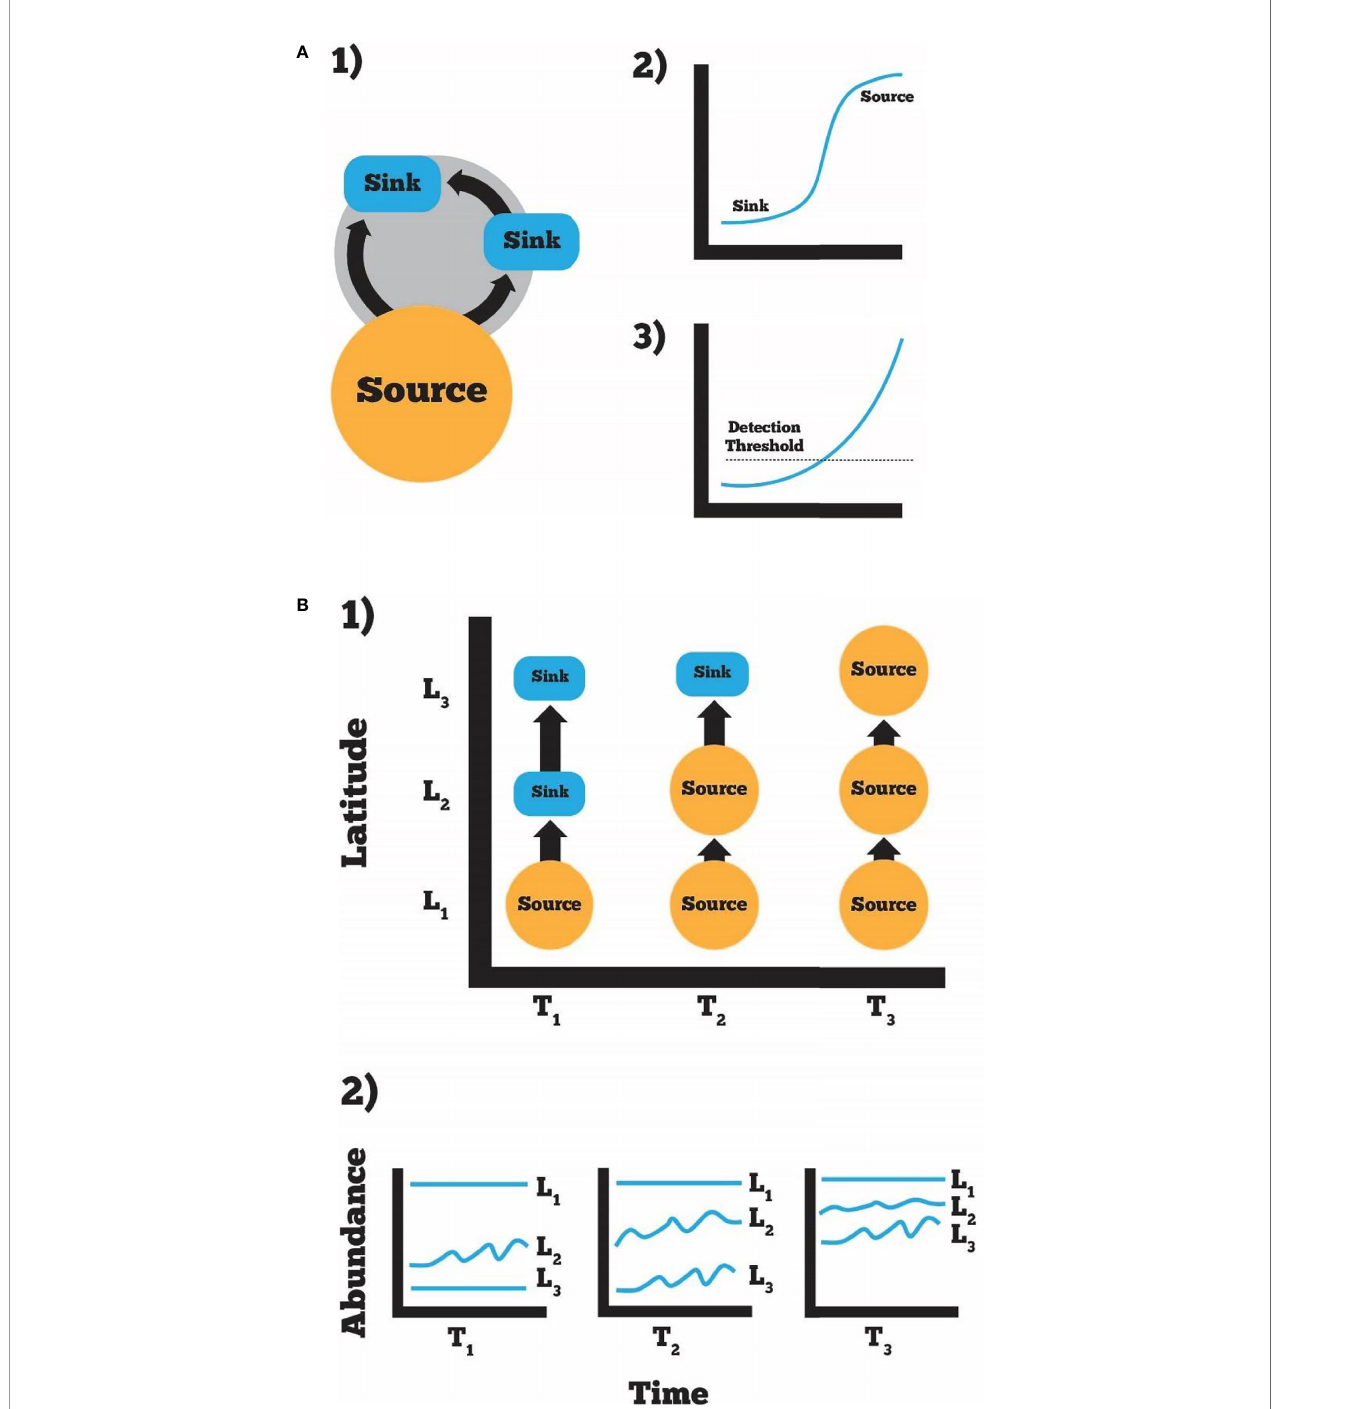
FIGURE 2 | Source-sink metacommunity ecology can inform the spread of warmer water species into areas not previously tolerable (Lockwood et al., 2013). We predict that early in the process, source populations may exist that fuel sinks during short-term, favorable conditions ( A , 1) and as temperatures continue to warm over time these sinks become sources ( A , 2). Novel organisms will be below a detectable threshold for many gear types and monitoring strategies early and as abundance increases become more detectable ( A , 3). Latitudinal abundance (L) will also change over time (T), as conditions change there will be less occurrences below a species thermal tolerance and sinks become source populations ( B , 1). In this way, we predict abundance will increase over time and species can move poleward in a stepwise fashion ( B ,